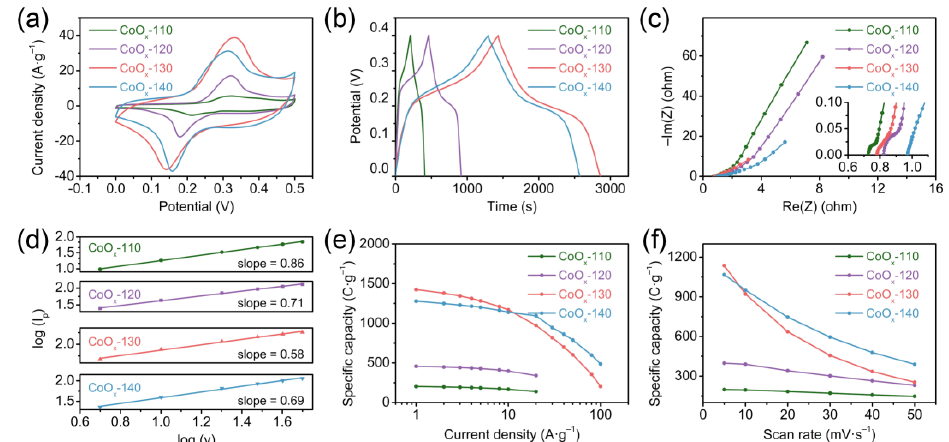
Figure 4. Electrochemical properties of the CoO x electrodes: ( a ) the CV curves at 5 mV s − 1 , ( b ) the GCD curves at 1 A g − 1 , ( c ) Nyquist plots, ( d ) the linear plots of log (I p ) versus log ( ν ), ( e ) specific capacities at various current densities, and ( f ) specific capacities at various scan rates.